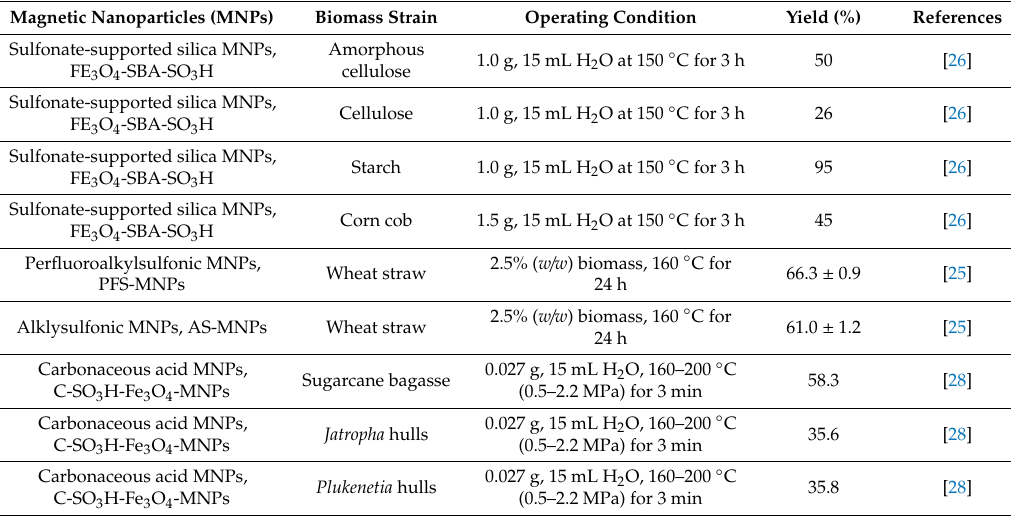
Table 2. Comparison studies on the e ffi ciencies of magnetic